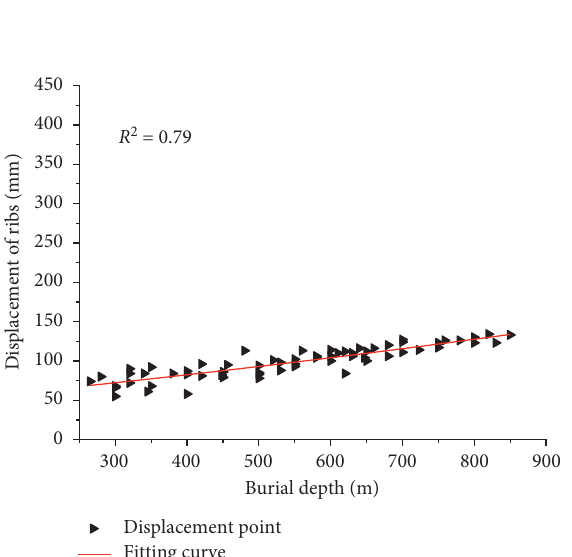
Figure 25: 40m away from the working face.